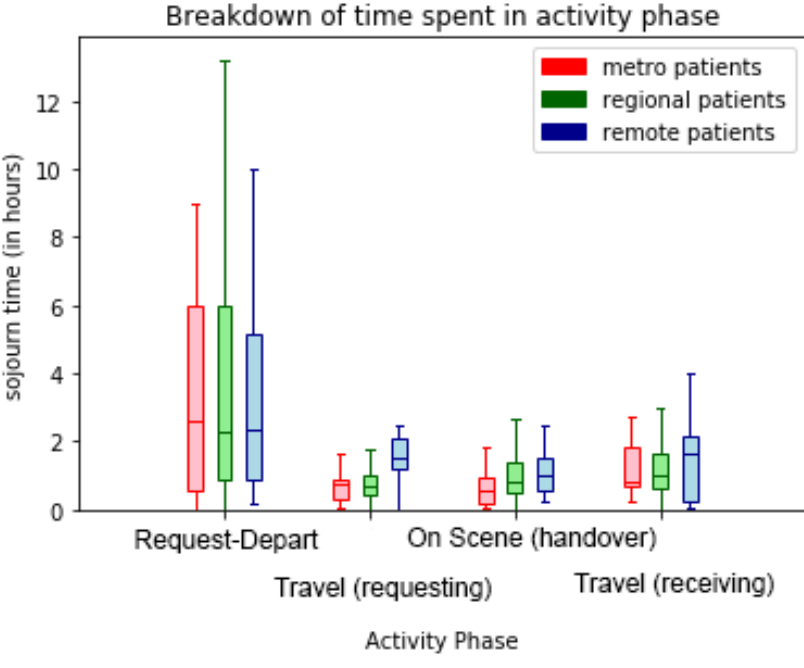
Figure 15. Comparison (by incident region) of inter-hospital transport segments